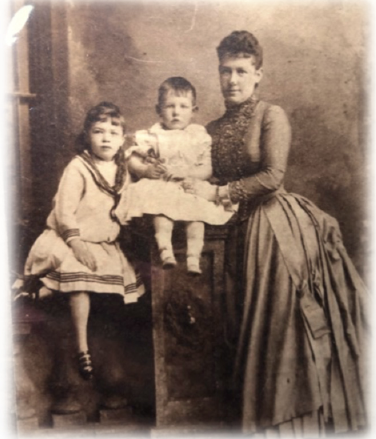
Figure 1. Vera Louise Holme on the left with her brother Richard (Gordon or Dick) Holme and her mother Mary Louisa Crowe, Vera Holme Papers, Women’s Library, LSE, London.